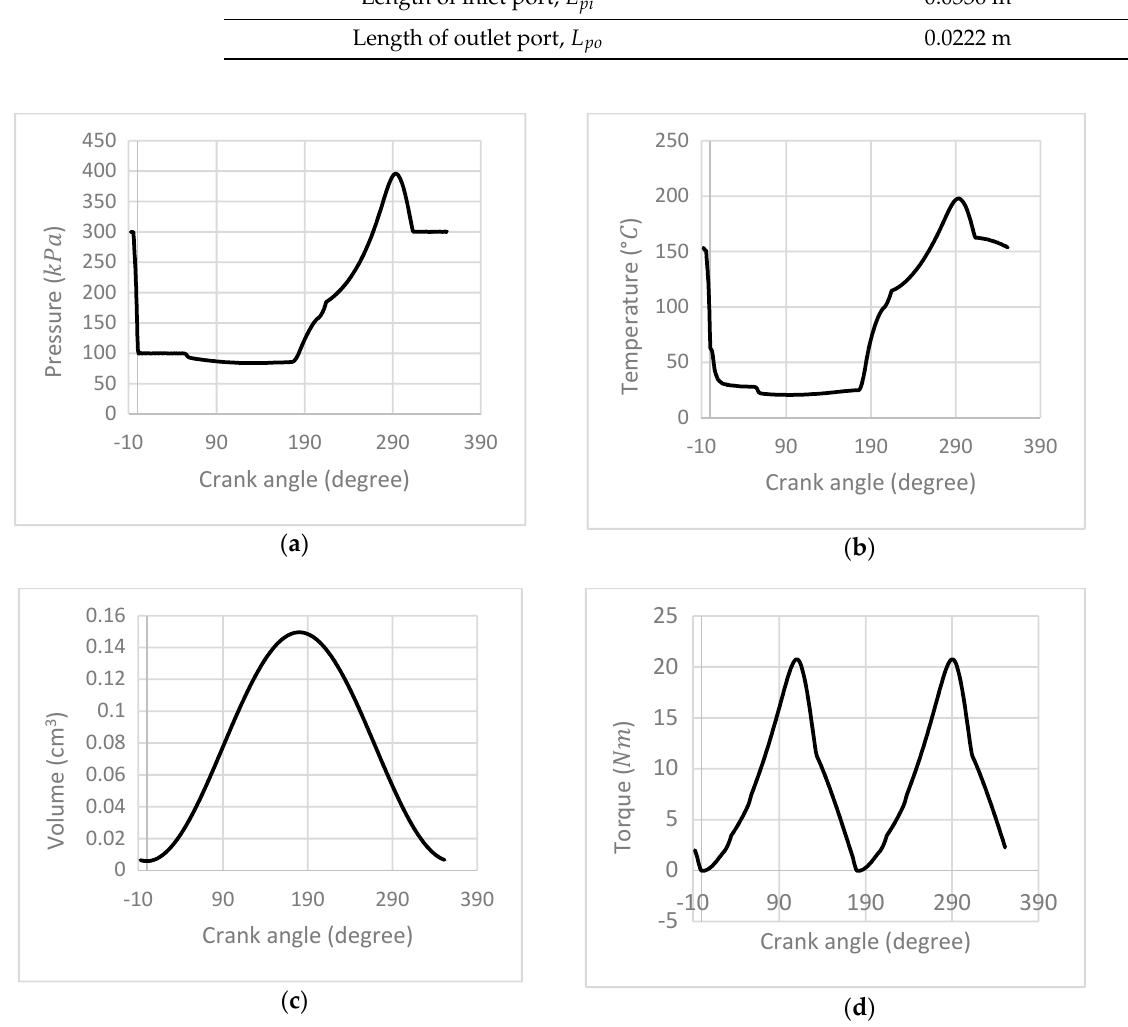
Figure 3. Variation of fluid properties; ( a ) pressure; ( b ) temperature; ( c ) volume; and ( d ) torque.